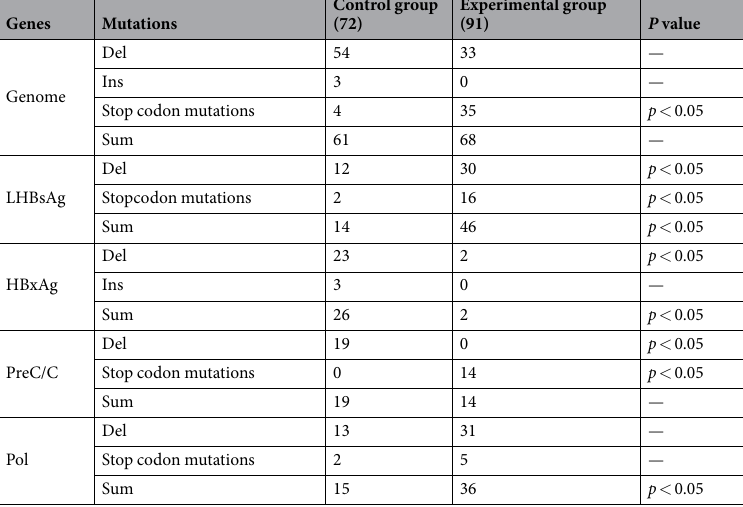
Table 5. The number of deletion, insertion, and stop codon mutations of HBV quasispecies